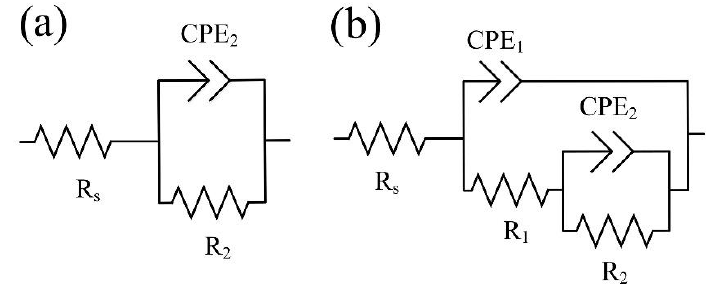
Figure 9. An equivalent electrical circuit was used to fit the EIS spectra for the S0 ( a ) and S1 – S3, S1 HTT – S3 HTT ( b ) samples. HTT–S3 HTT ( b )